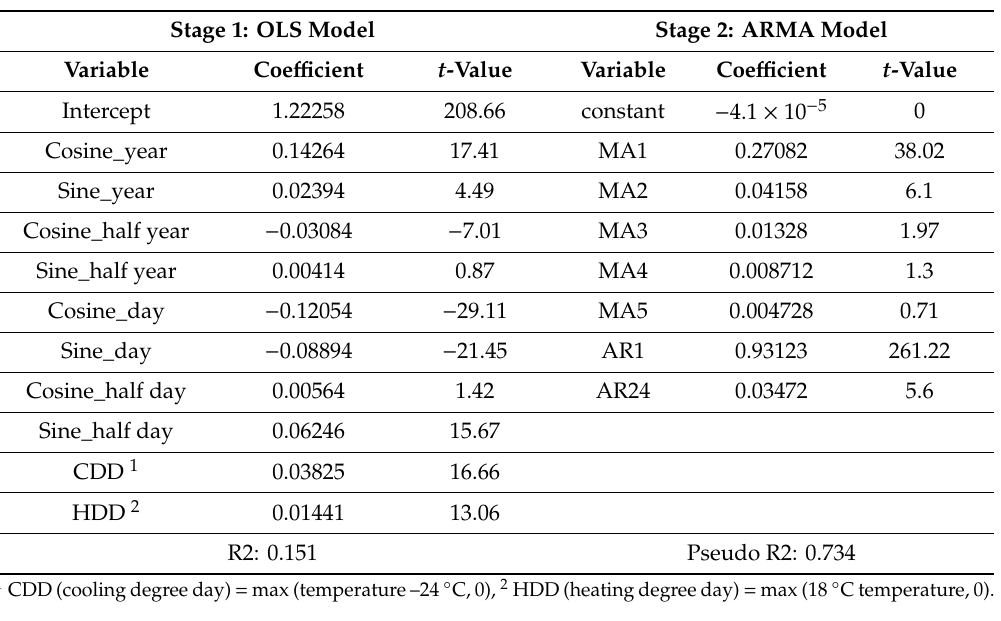
Table 1. Two-stage ARMAX (autoregressive moving average with exogenous variables) estimation results for Wind1 (Hanlim).